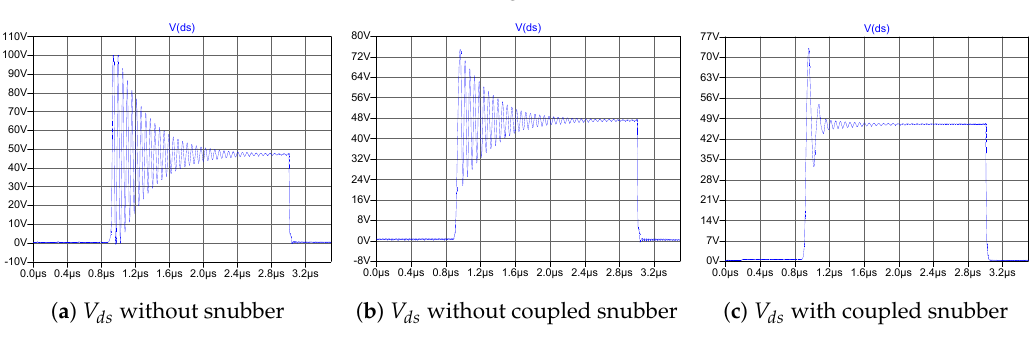
Figure 10. Simulation results for the voltage across the MOSFET switch “ V in = 28 V”.